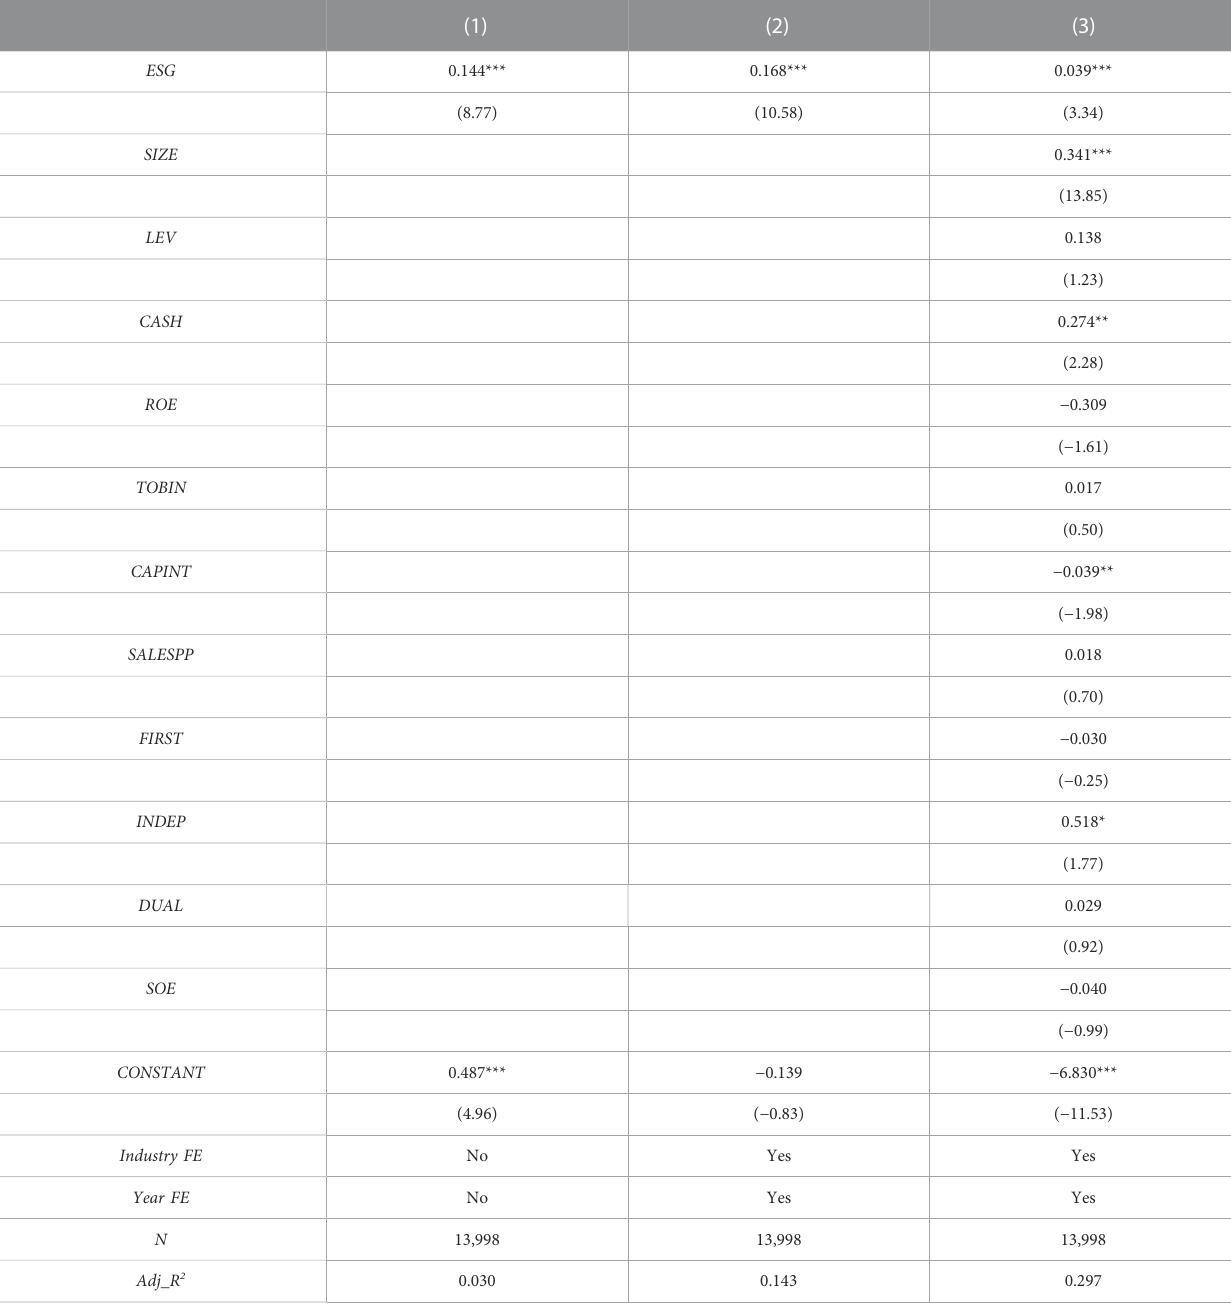
TABLE 3 Baseline estimation